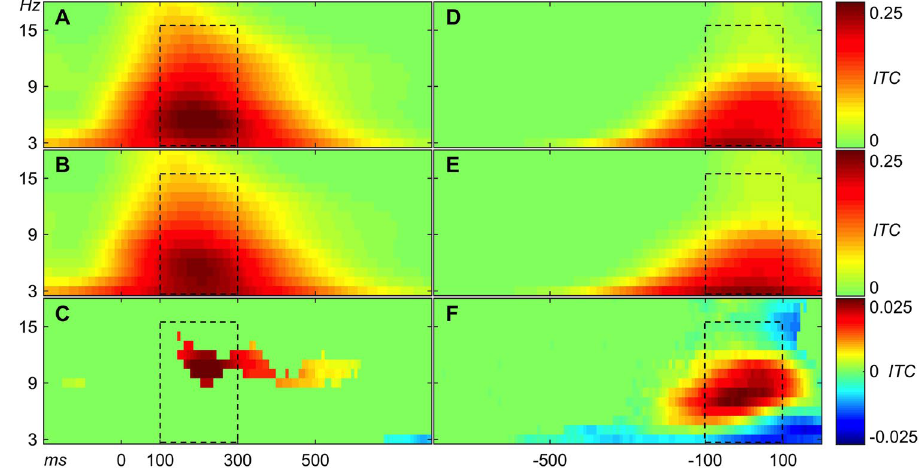
Figure 5. ( A ) Average ITC over 600 Sensory ICs. ( B ) Average ITC over 343 SensoriAverage ITC plots of Sensory, Motor, and Sensorimotor ICs. motor ICs. ( C ) Average ITC of Sensory ICs minus average ITC of Sensorimotor ICs. Note that colour-coding of subtraction is ten times amplified relative to panels A and B. 0 ms in plots ( A,B , and C ) indicate stimulus onset ( D ). Average ITC over 132 Motor ICs. ( E ) Average ITC over 343 Sensorimotor ICs. ( F) Average ITC of Motor ICs minus average ITC of Sensorimotor ICs. Note that color-coding of subtraction is ten times amplified relative to panels D and E. 0 ms in plots ( D,E , and F ) indicate motor onset (button-press event). Panels C and F were masked according to two-sample t-test with p-value threshold < 0.01. The black dashed rectangles represent the same time-frequency windows of interest as in Fig. 3.